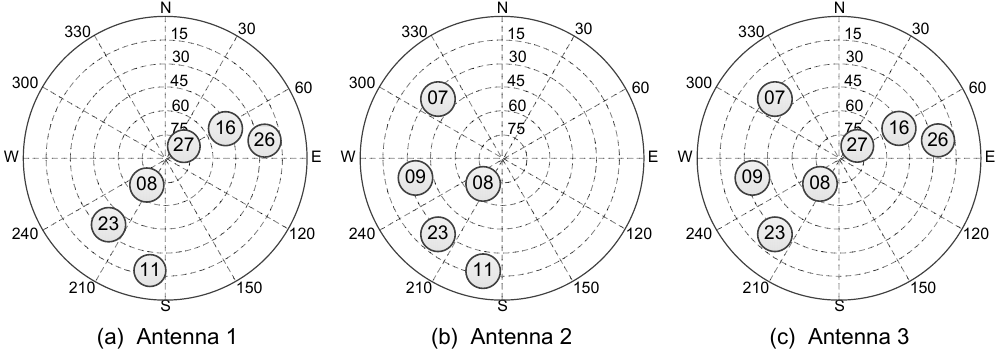
Figure 12. The visible satellites of each